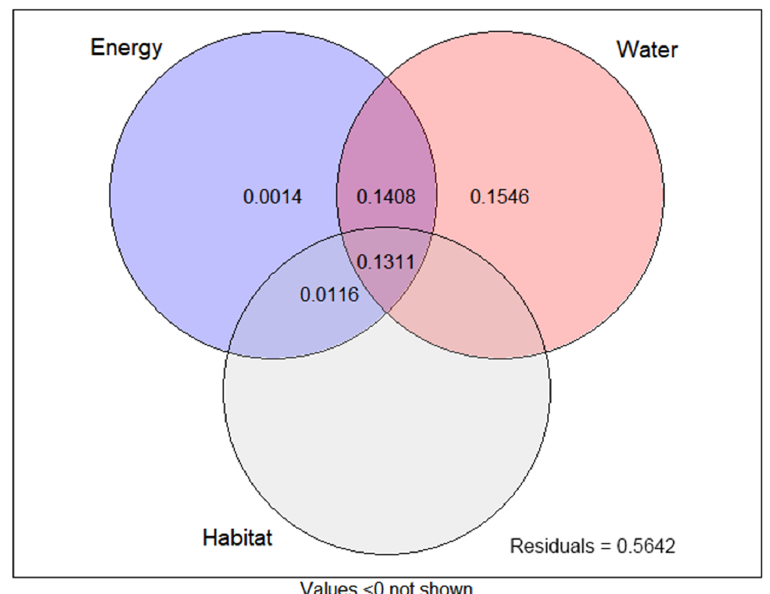
Figure 5. Variance partitioning (proportions) of species richness for Wetland angiosperms into the independent effects of energy, water, and habitat variables, and their overlaps.